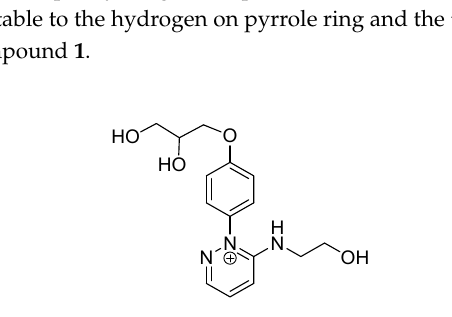
Figure 12. Hypothesized chemical structure of compound 1 .